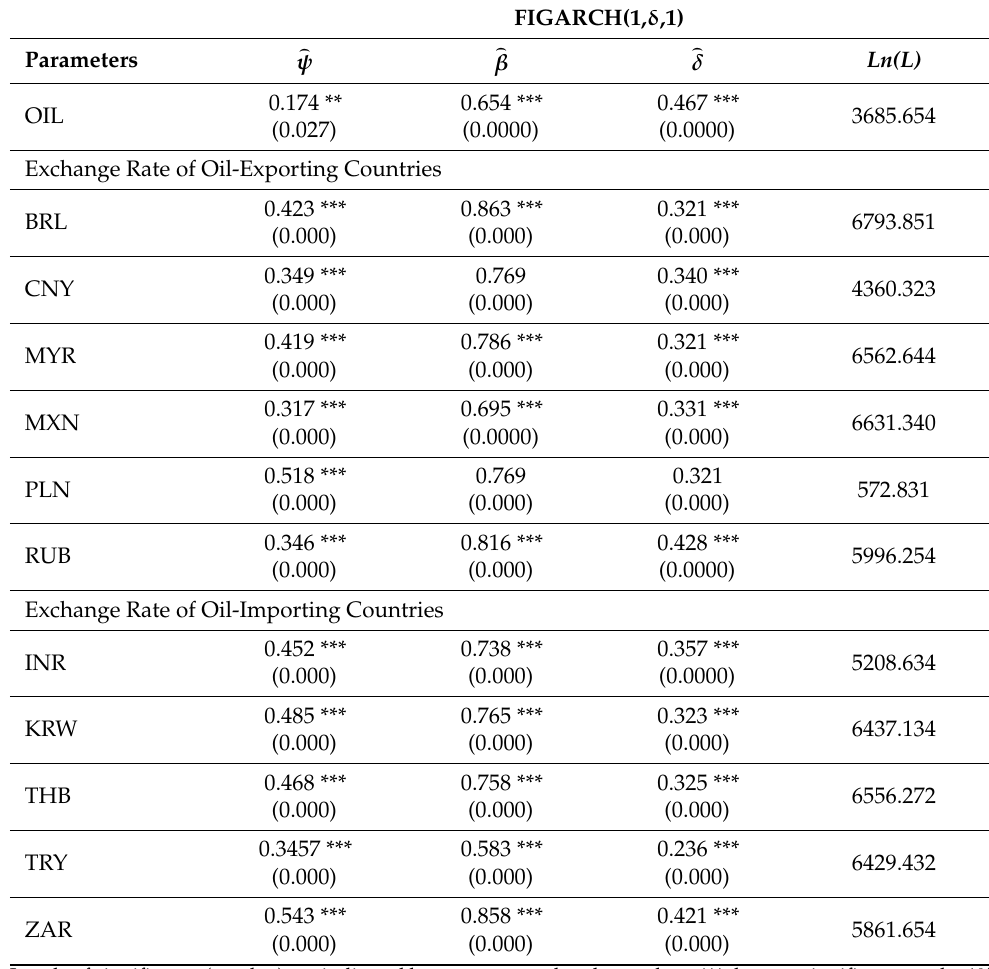
Table 5. Conditional variance equation